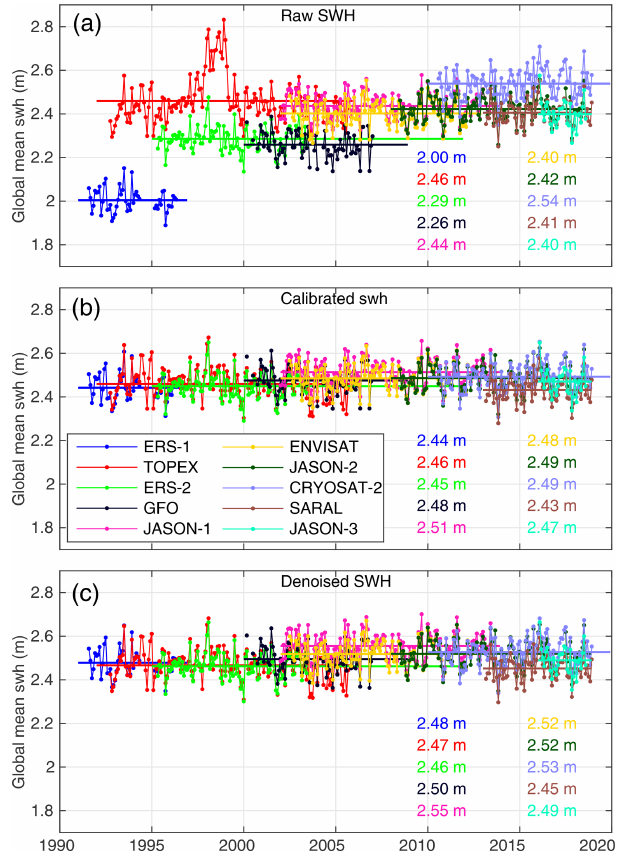
Figure 12. Monthly global mean of raw (a) , calibrated (b) and de- noised (c) SWH over the period 1991–2018. The horizontal lines and the values correspond to the mean values computed for each mission over the duration of the